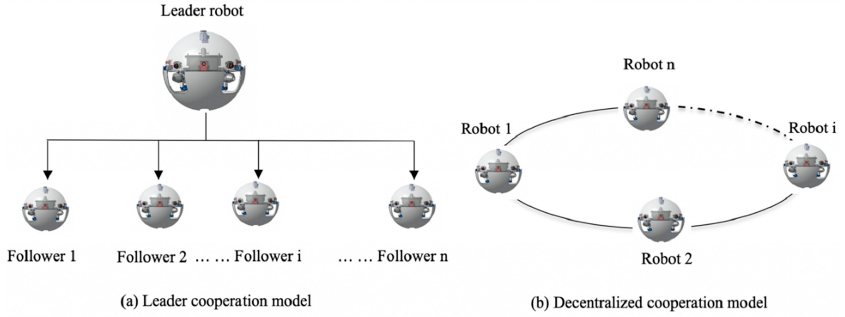
Figure 1. Schematic of the multi-robot cooperation (this study uses ( a ) mode: n = 3). ( a ) Leader cooperation model; ( b ) Decentralized cooperation